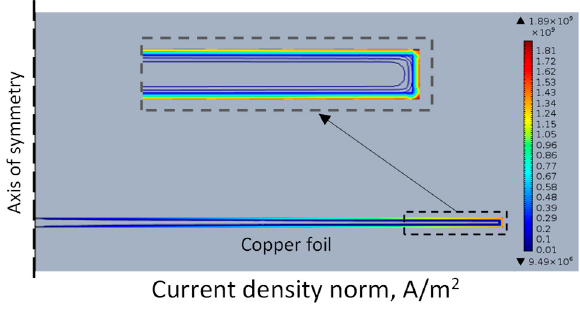
Figure 13. Current density contours along the copper foil.